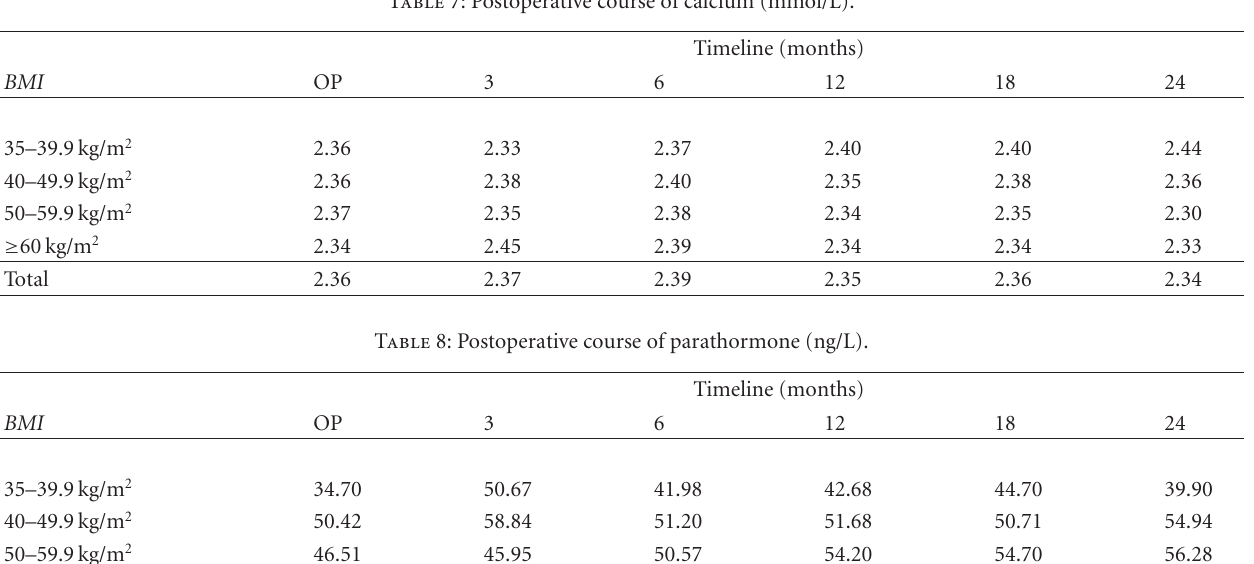
Table 7: Postoperative course of calcium (mmol/L).